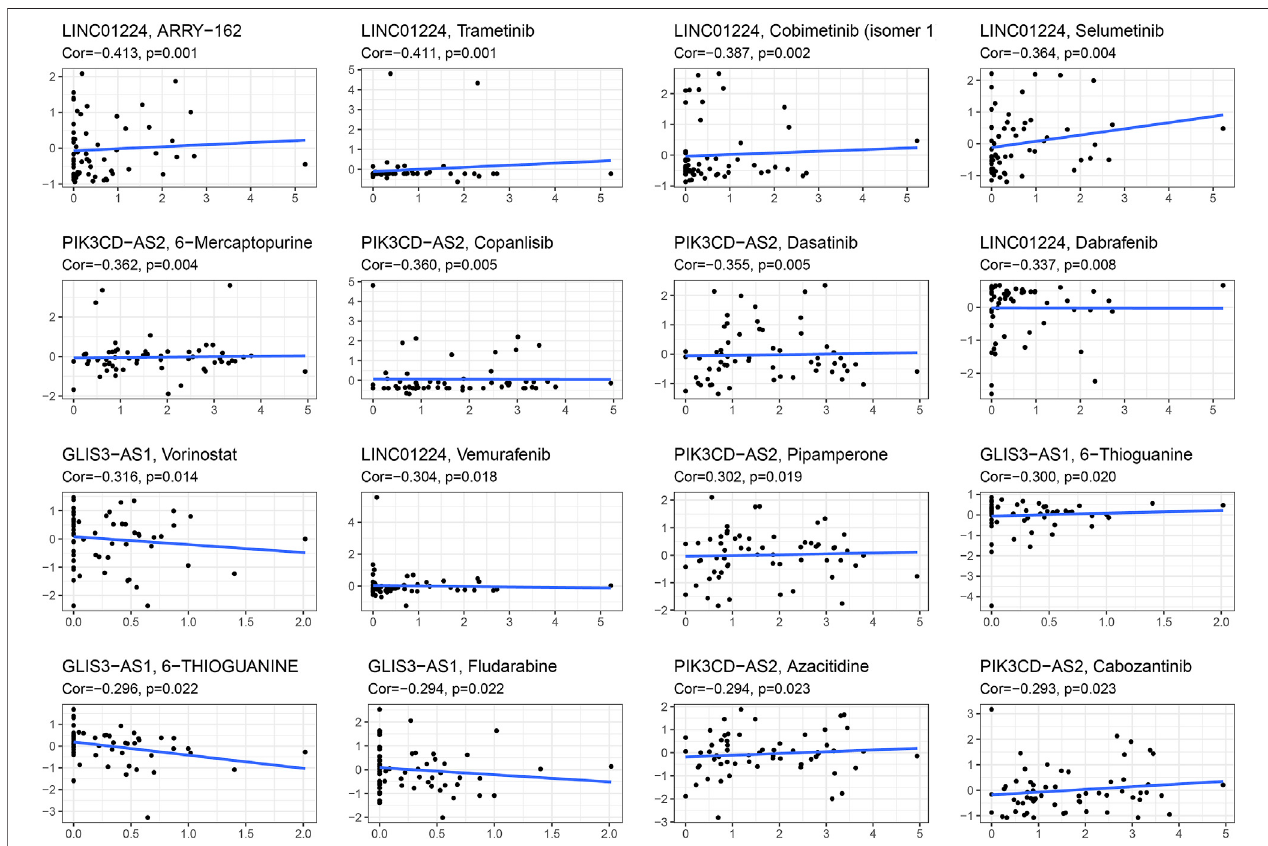
FIGURE 9 | Scatter plot of relationship between the expressions of lncRNAs related to genetic instability and drug sensitivity.